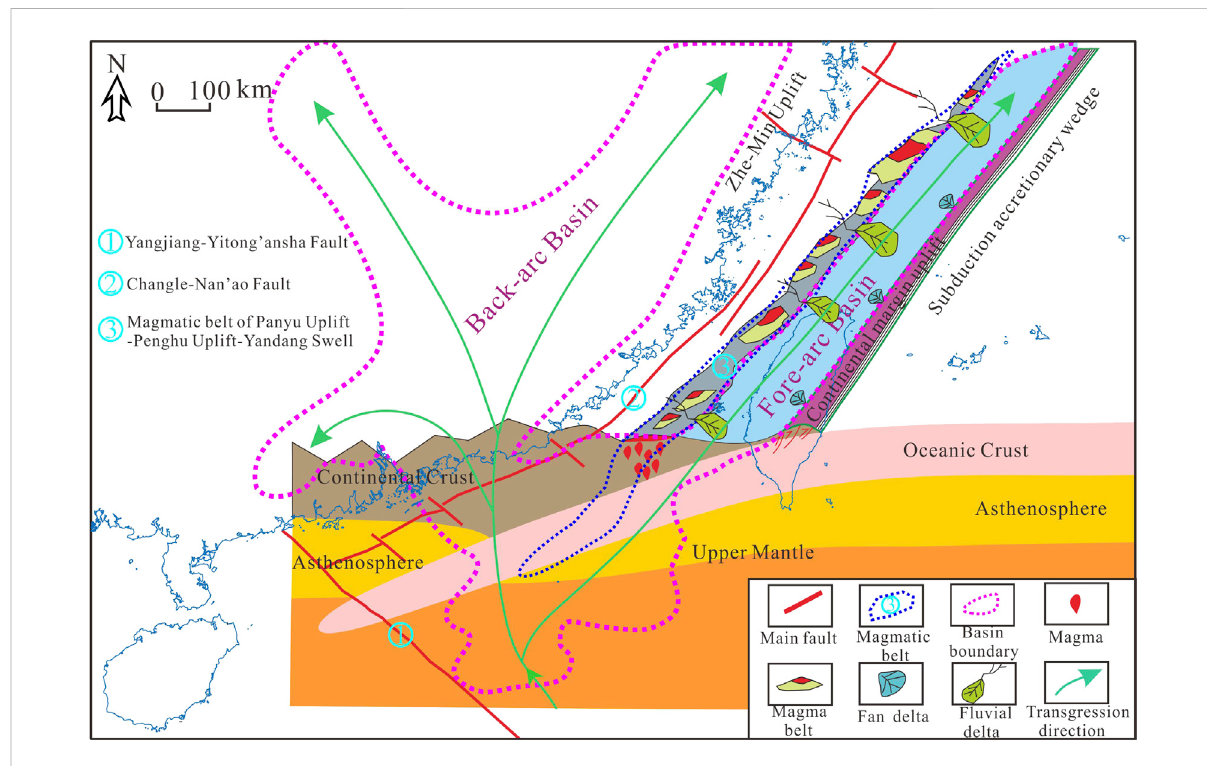
PlaneviewoftheEarly – MiddleJurassicBasin(pinkdottedlines)andtransgressiondirection(greenarrowlines)intheNSCS-SECS,aswellasthe sedimentary system in the SECS. In the vertical section, we show the deep structural features, the magma activity, and the basin formation mechanism (modi fi ed from Zhou et al., 2005; Yi et al., 2012; Wu, 2014; Wang et al., 2022a;